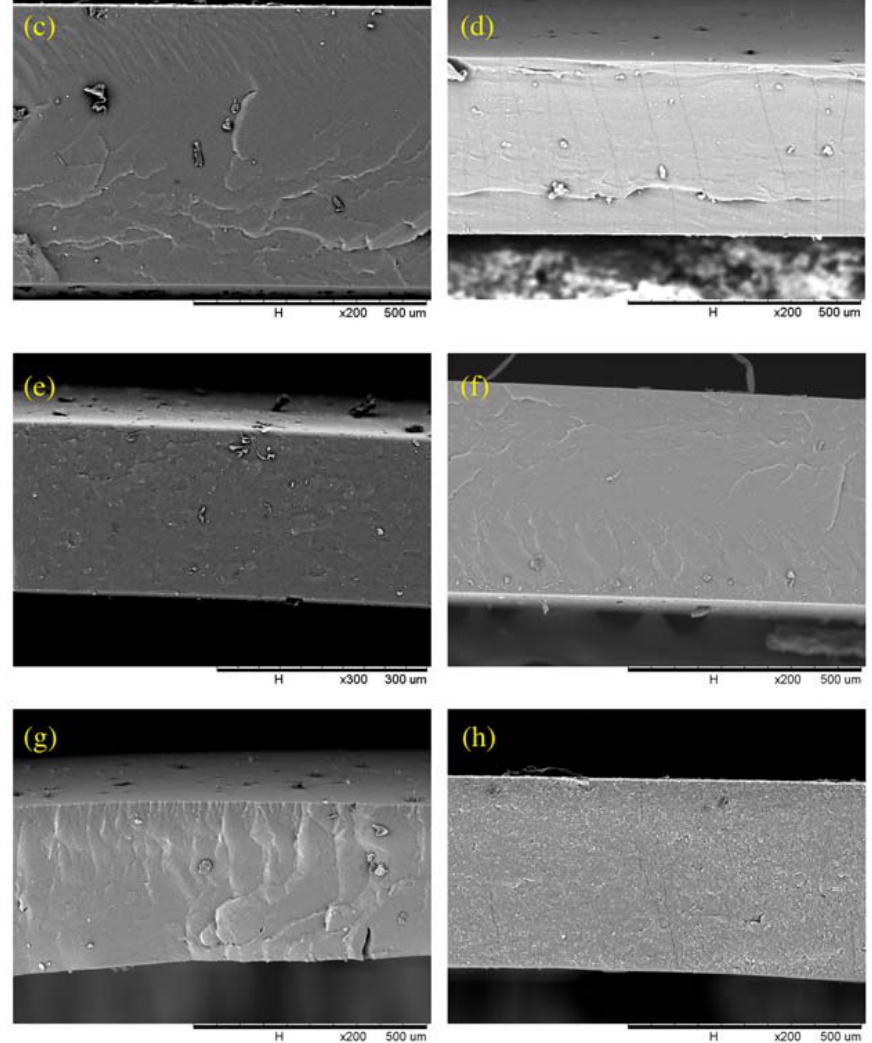
Figure 4. Cross-sectional images of ZIF-L@PDMS flat sheet membrane at ZIF-L loading of ( a ) 0 ( b )